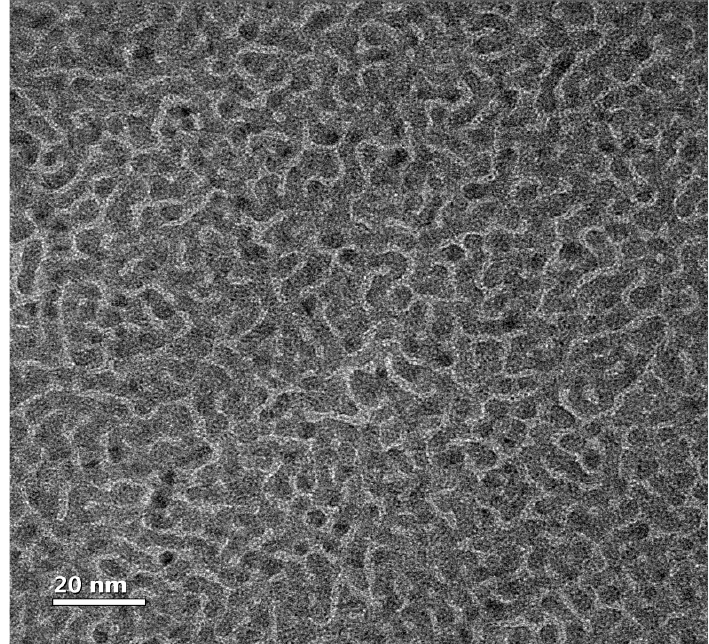
Figure 2. TEM micrograph of the 5 nm thick Pd film. Pd is